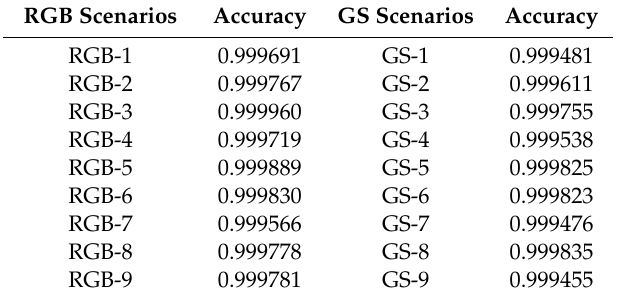
Table 8. Accuracy Comparison of RGB and grayscale in multiclass classification of KDD.